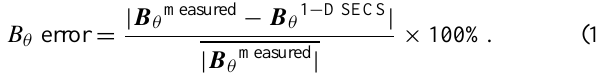
Fig. 4. Left: Top: B θ measured by CHAMP on 6 November 2001 at 05:04–05:08 UT above IMAGE, and the 1D SECS B θ attained by fitting B r . The similar shapes of the two curves (error 45%) imply that the current distribution is reasonably 1D during the overflight. Bottom: J φ determined from CHAMP data by the 1D SECS method and from IMAGE data by the 2D SECS method. As expected in a 1D case, the two profiles are almost the same. Right: The same as on the left hand side, but on 20 November 2001 at 03:59–04:04 UT.